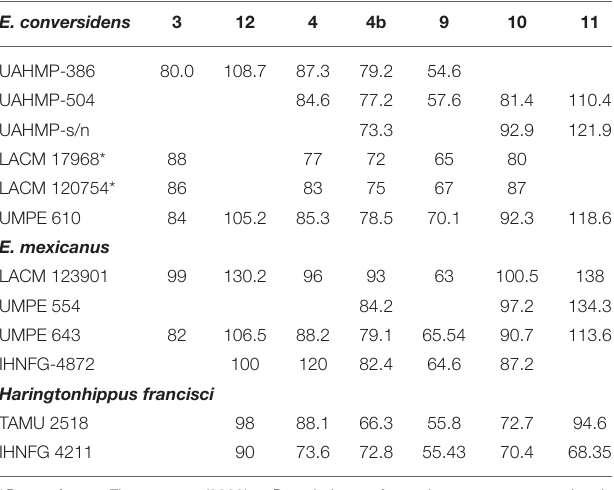
TABLE 2 | Measurements of equid mandibles from the Pleistocene of southern Mexico and other selected specimens from North